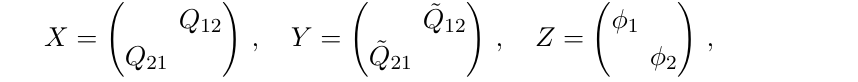
to give the U( N ) = U(2 N ) flavour symmetry of L f